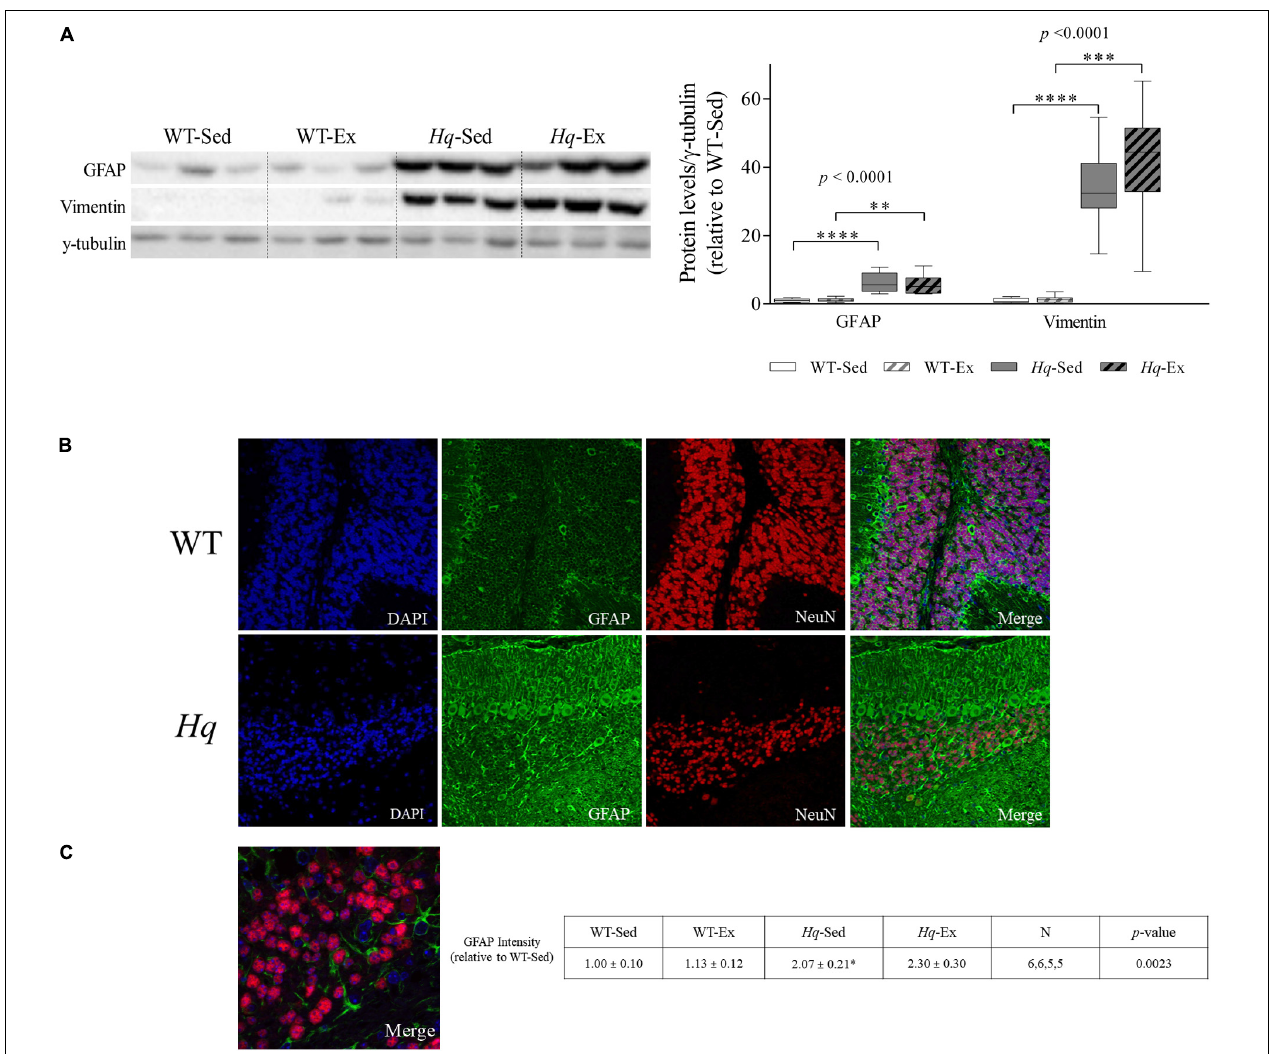
FIGURE 6 | Astrogliosis markers. (A) Western blot analysis of glial fibrillary acidic protein (GFAP) and vimentin in cerebellum homogenates of wild-type sedentary (WT-Sed, n = 12) and exercise-trained (WT-Ex, n = 11) mice, and of Hq sedentary ( Hq -Sed, n = 11) and exercise-trained ( Hq -Ex, n = 10) mice. Densitometry analysis: protein levels were normalized to γ -tubulin levels; data (median, interquartile range, and min and max values) are expressed relative to levels in the WT-Sed group. Significant p- values for the group effect (Kruskal-Wallis test) are shown above the corresponding bars. Symbols for significant differences in post hoc pairwise comparisons: ∗ p < 0.05; ∗∗ p < 0.01; ∗∗∗ p < 0.001; ∗∗∗∗ p < 0.0001 for Hq -Sed vs. WT-Sed, and Hq -Ex vs. WT-Ex. (B) Immunodetection of GFAP (green) and NeuN (red), cell nuclei (blue) and merged images in representative sedentary WT and Hq mice (10 × ). Inmunofluorescence semi-quantitation was performed in 6 WT-Sed, 6 WT-Ex, 5 Hq -Sed and 5 Hq -Ex animals (1 section per mouse). Only representative WT-Sed and Hq -Sed images are shown for simplicity purposes, due to absence of training-induced effect. (C) Higher magnification images showing direct interaction between GFAP-positive astrocytes (green) and granule neurons (red) in a representative sedentary Hq mouse (63 ×